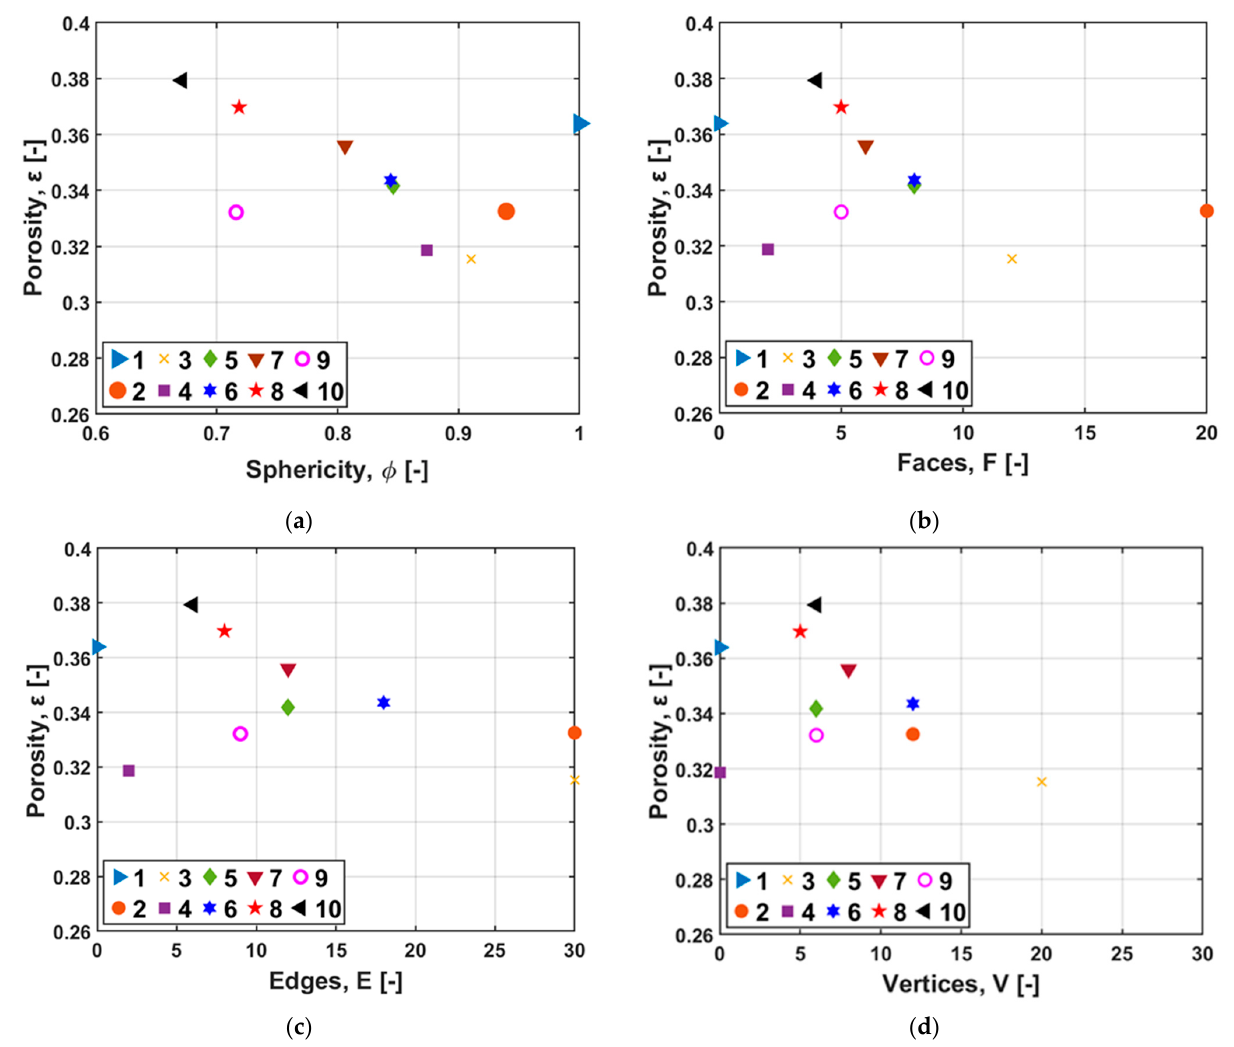
Figure 4. Variation of porosity with particle shape parameters for respective particle IDs: ( a ) sphericity; ( b ) number of faces; ( c ) number of edges; and ( d ) number of vertices. Table 2. Results of ε , ετ , and τ for different particle shapes and their deviation among three realizations.